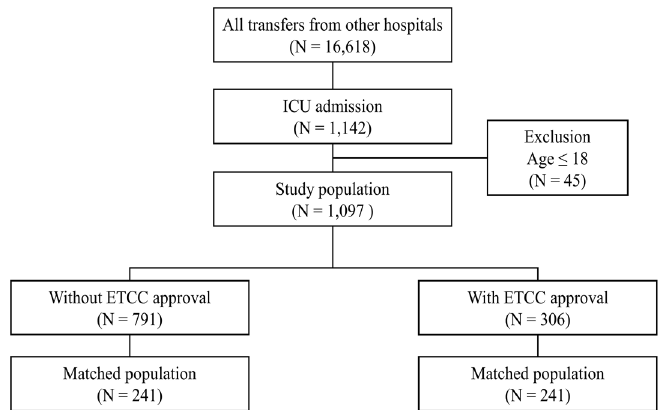
Figure 2. Flowchart of patient inclusion. ICU, intensive care unit; ETCC, emergency transfer coordination